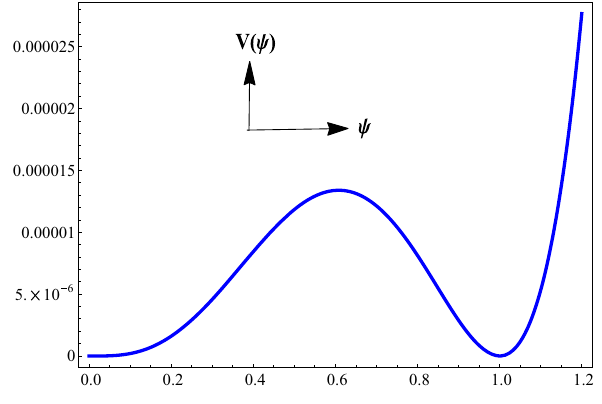
Fig. 1 U rad ((cid:13)) vs. (cid:13) for M = k = 1 (in Planck units), σ = 0 . 04, κv v = 10 − 7 , v h = 1 . 2 and α = 1 v v M